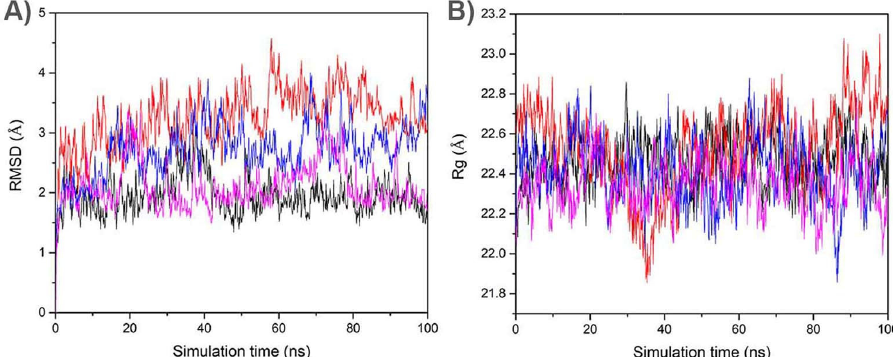
Figure 1. ( A ) RMSD and ( B ) Rg values of the complexes between KRas4B WT –PDE6 δ or KRas4B G13D – PDE6 δ with C19 or I-C19. RMSD (left) values of KRas4B WT –PDE6 δ -C19 (black line) KRas4B G13D – PDE6 δ -C19 (red line), KRas4B WT –PDE6 δ -I-C19 (blue line), and KRas4B G13D –PDE6 δ -I-C19 (magenta line). Rg (right) values of KRas4B WT –PDE6 δ -C19 (black line), KRas4B G13D –PDE6 δ -C19 (red line),